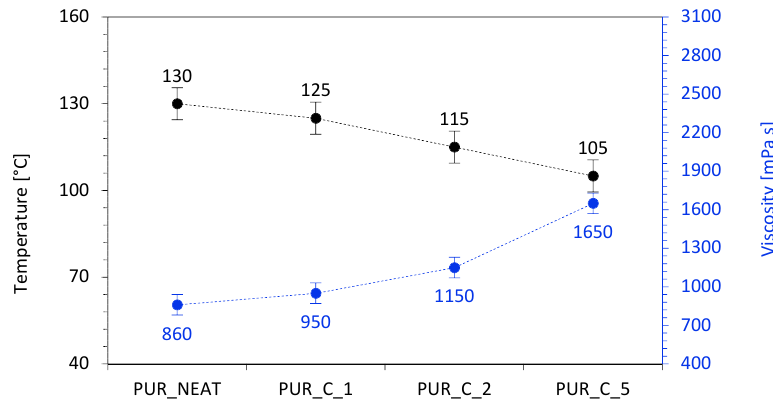
The addition of coir-fiber filler decreased the maximum temperature (T max ) measured during the PUR synthesis (Figure 7). On the addition of 1, 2, and 5 wt % of the coir-fiber filler, the value of T max decreased from 130 °C (for PUR_NEAT) to 125, 115, and 105 °C, respectively. This may be connected with the increased viscosity of the PUR systems with the addition of coir-fiber filler, which effectively reduced the efficiency of the reaction between functional groups of the components. Moreover, previous studies have shown that decreased temperature of PUR reinforced with natural fillers may be connected with the fact that during the foaming process, some heat is absorbed by the filler [45]. A similar explanation may be found in our study as well.